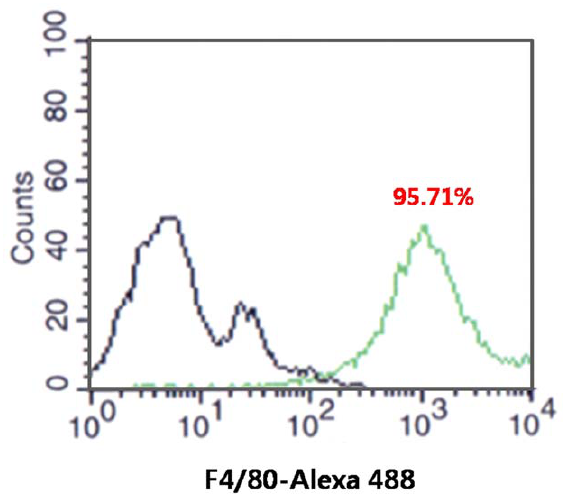
Figure 1. Identification of macrophages in the intraperitoneal cells by FACS. Over 95% of the intraperitoneal cells were F4/80 positive (Black: no staining, Green: F4/80 staining).